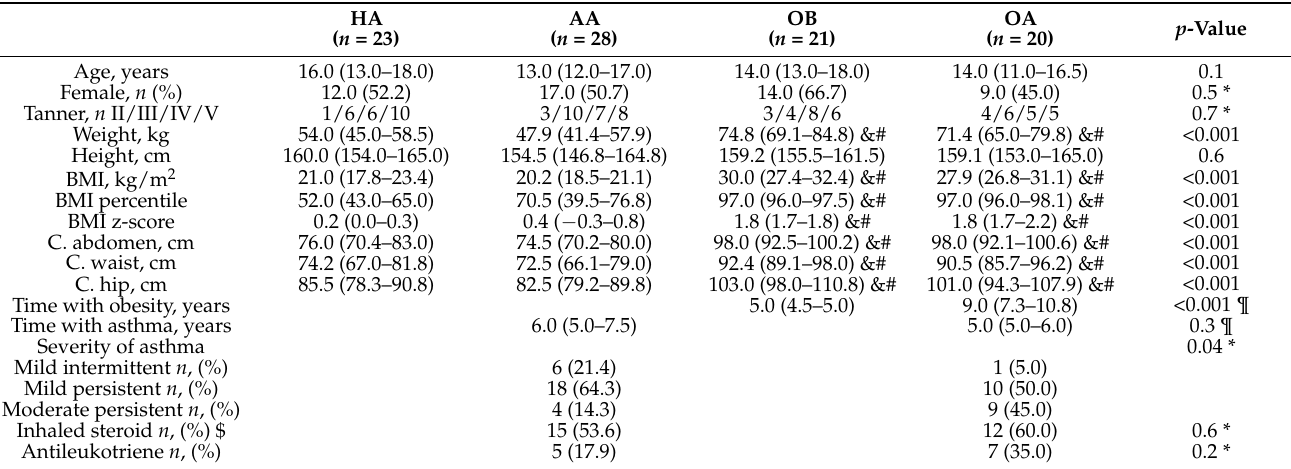
Table 1. Patient Characterization.